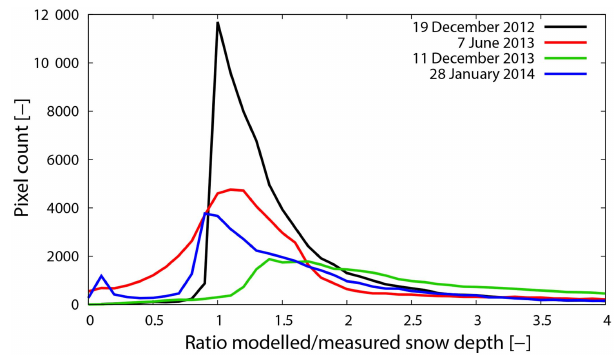
Figure 3. Histogram of measured and modelled snow depth data. Solid lines denote the distribution of the ratio modelled over mea- sured snow depth for the 4 TLS available. The TLS of 19 Decem- ber 2012, 7 June 2013 and 28 January 2014 are centred by 1. The TLS of 19 December 2012 was used for precipitation scaling and shows the best agreement between modelled and measured snow